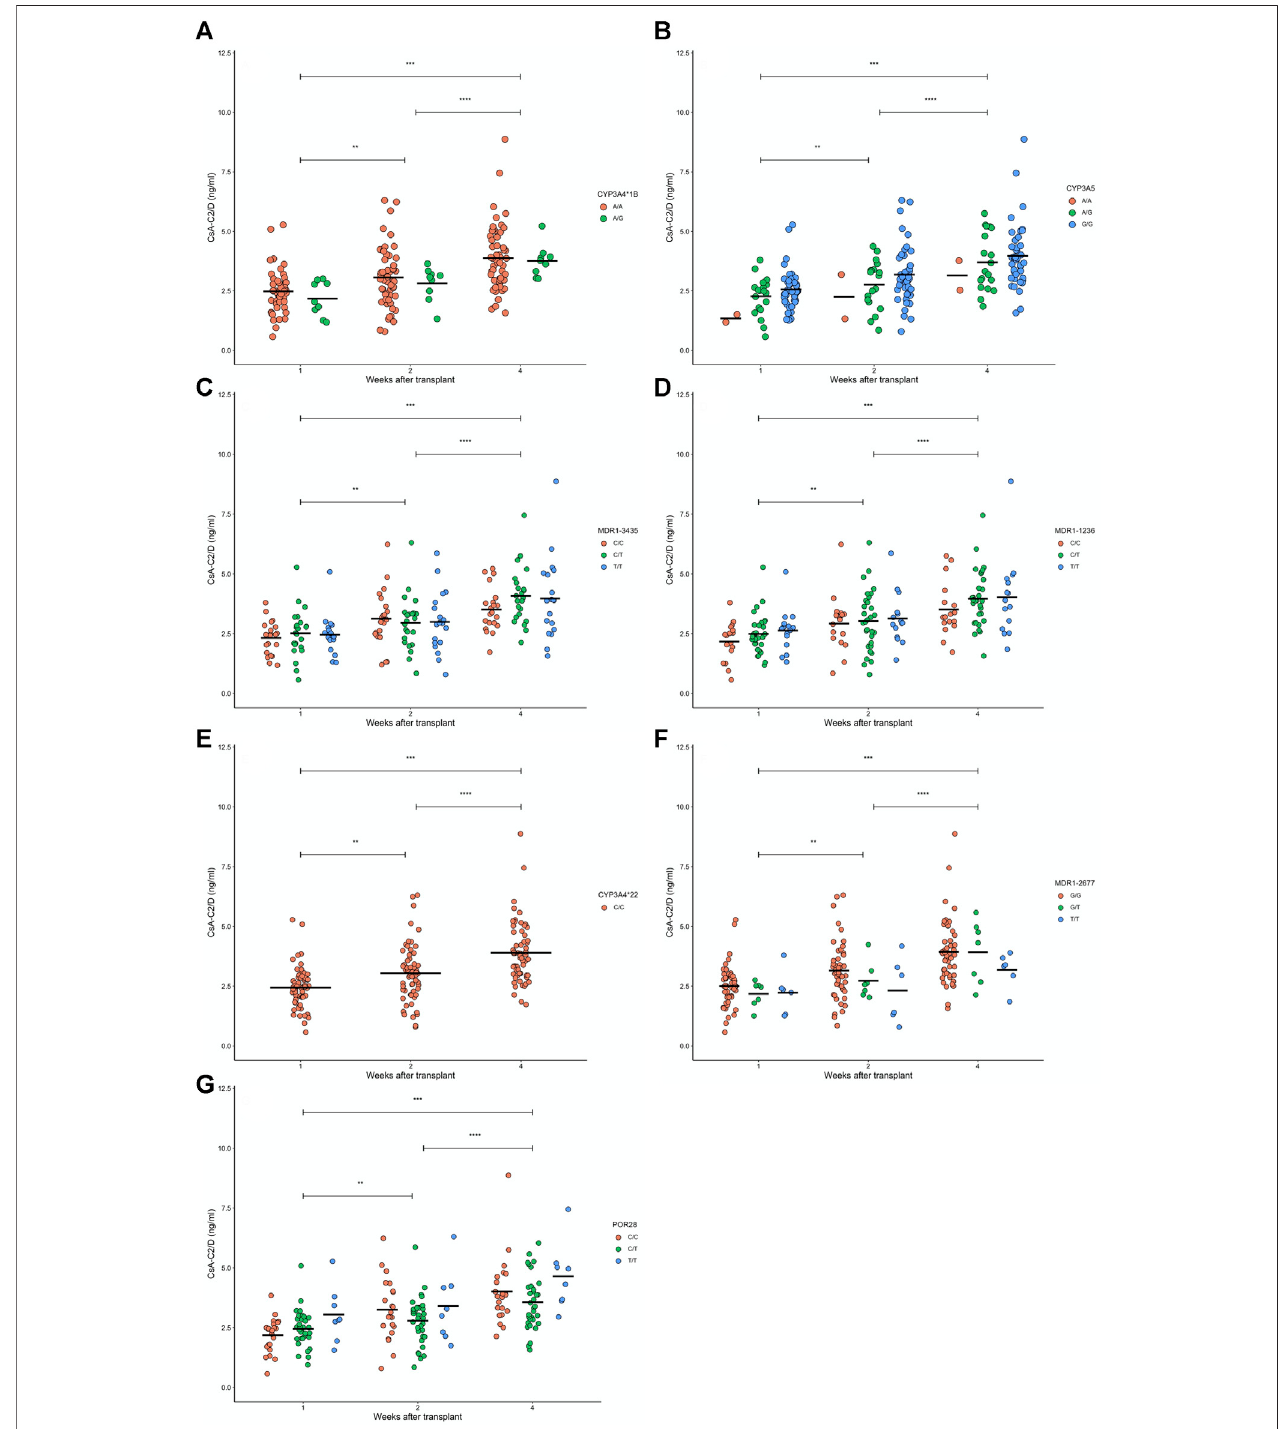
FIGURE 2 | Levels of cyclosporine (CsA) normalized by dose after 2 h of administration (CsA-C0/D) after 1, 2 and 4 weeks of renal transplant for 139 patients with different (A) CYP3A4*1B, (B) CYP3A5, (C) MDR1-3435, (D) MDR1-1236, (E) CYP3A4*22, (F) MDR1-2677,and (G) POR28genotypes.ForCsA-C0/D,non-differences were found between genotypes, but signi fi cance differences were found along time after transplantation (see Supplementary Table S1 ). Paired week comparisons using Bonferroni-adjusted t- tests are indicated as non-signi fi cant (ns: p > 0.05) or signi fi cant (* p < 0.05, ** p < 0.01, *** p < 0.001, and **** p < 0.0001).